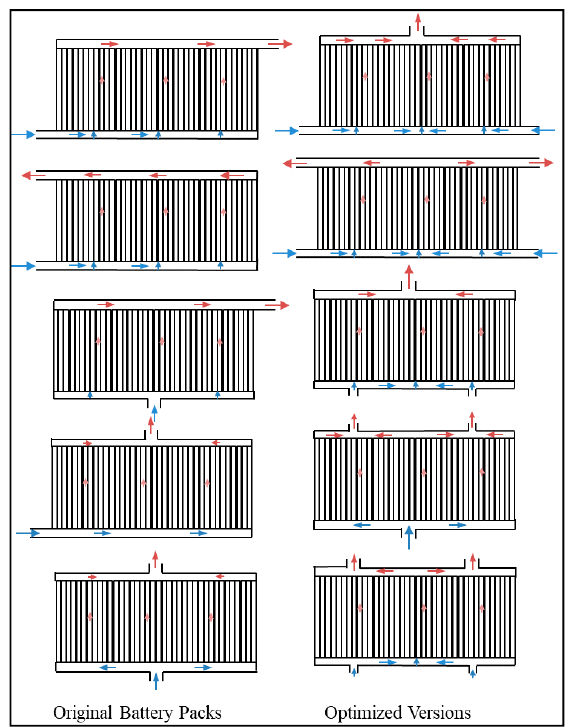
Figure 3. Asymmetrical vs. symmetrical BTMS battery packs adapted from [4,12].